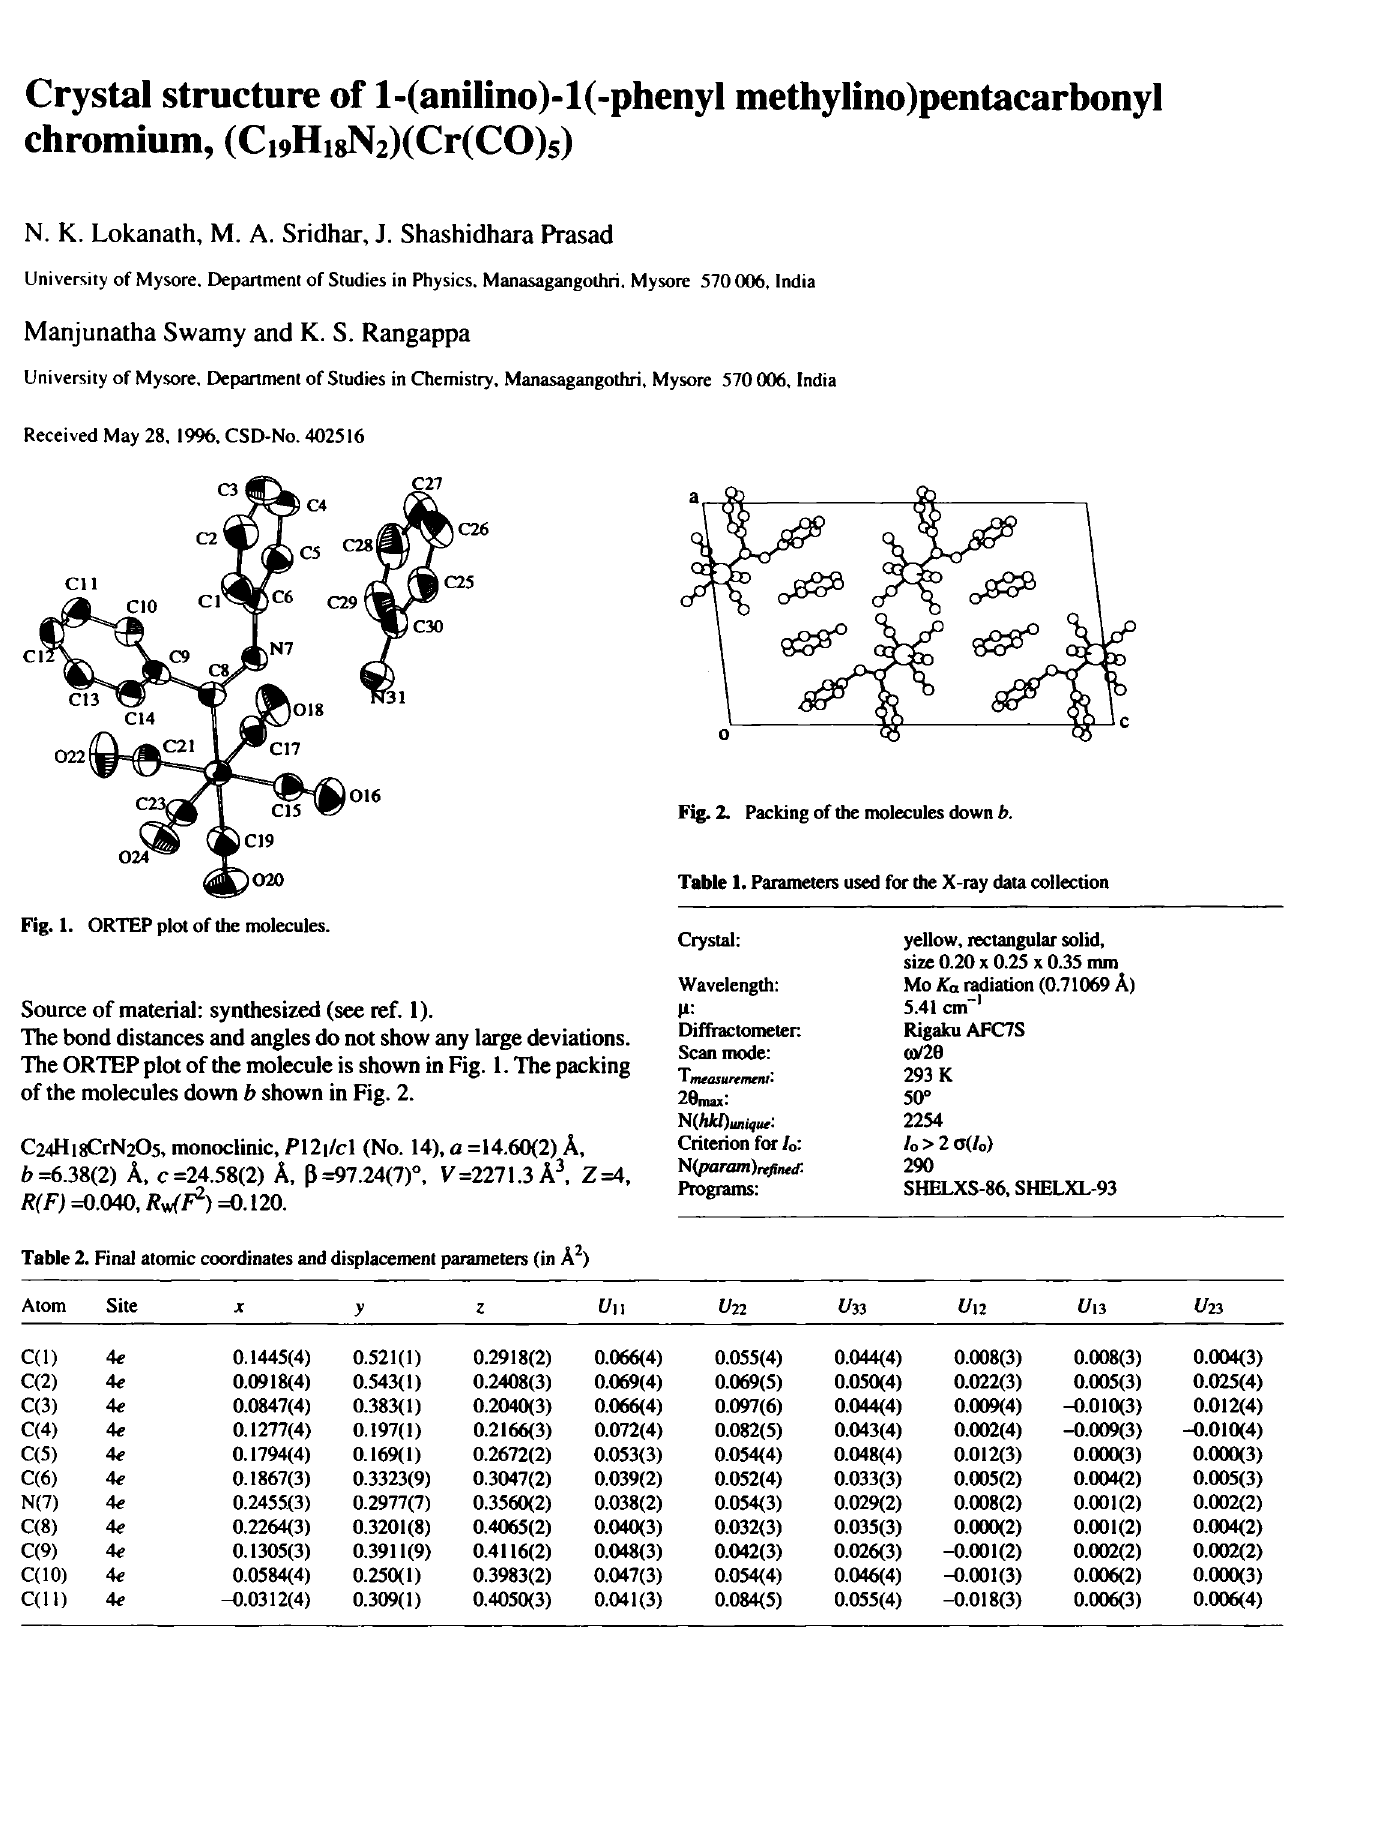
Table 2. Final atomic coordinates and displacement parameters (in Â 2 )